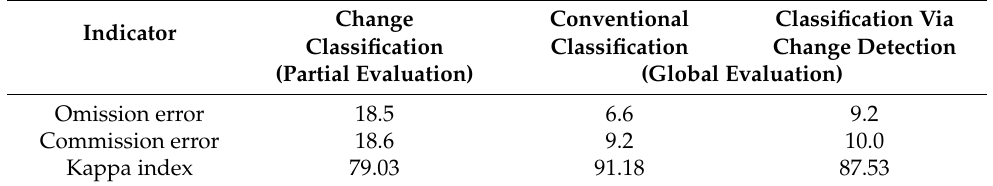
Table 6. Summary of the leading indicators of the confusion matrices applied for assessing the LULC maps generated by conventional classification and through change detection, applied to the test dates (2011), and evaluated with same-date ground-truth data.